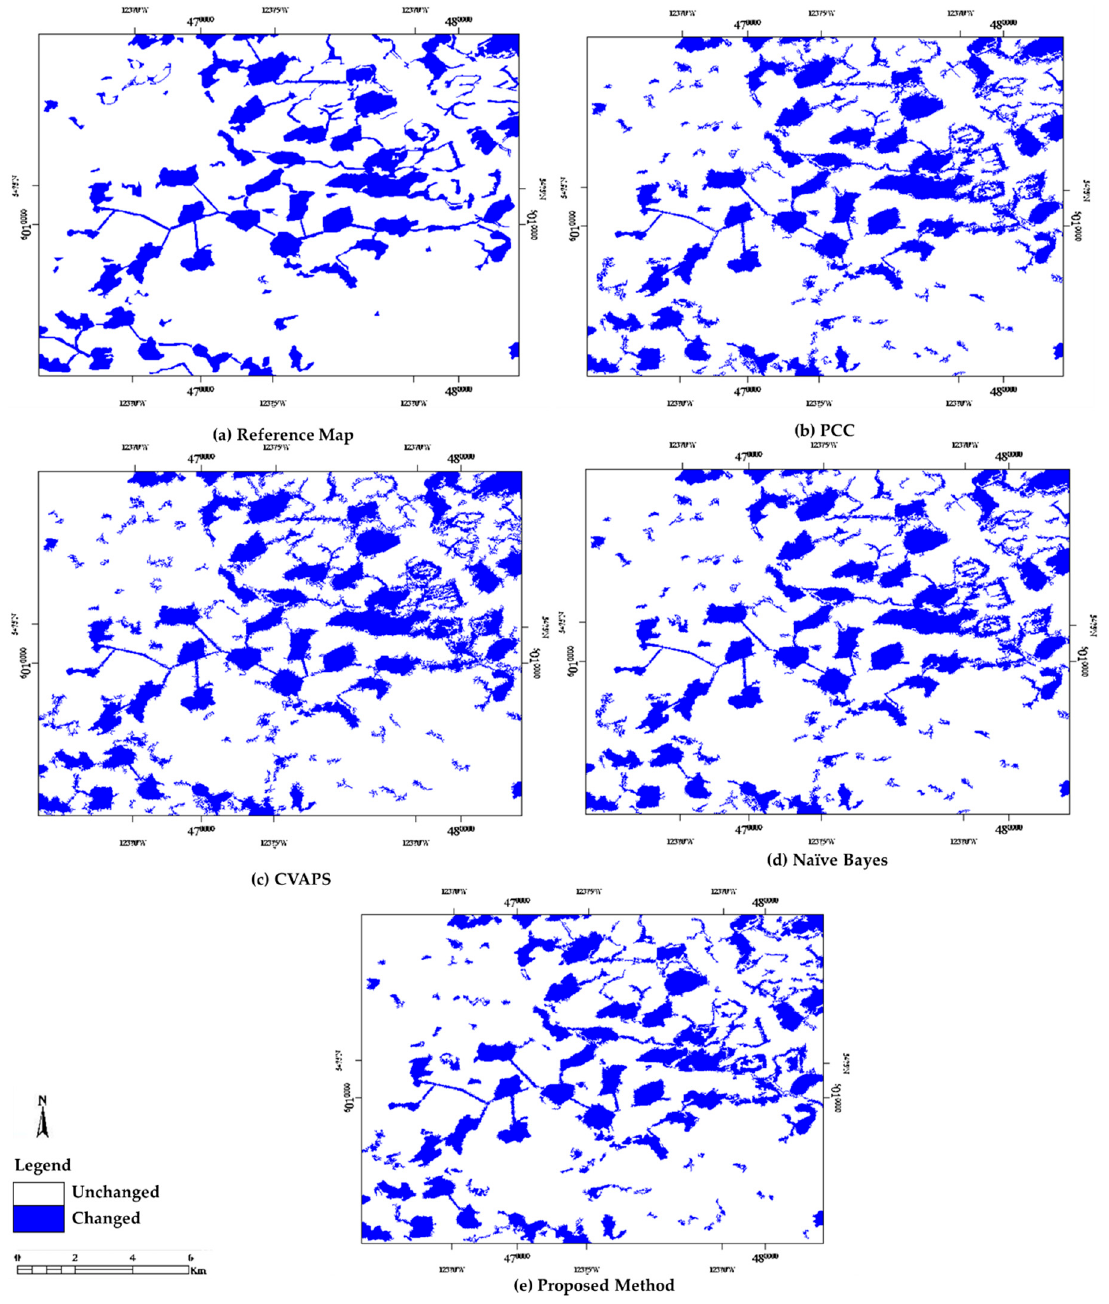
Figure 5. Change maps obtained from the Experiment I data set.